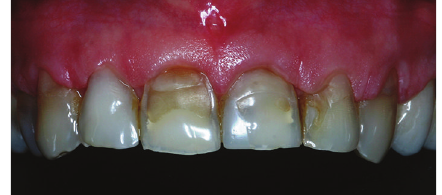
Figure 10: Soft tissue health two weeks after surgery.